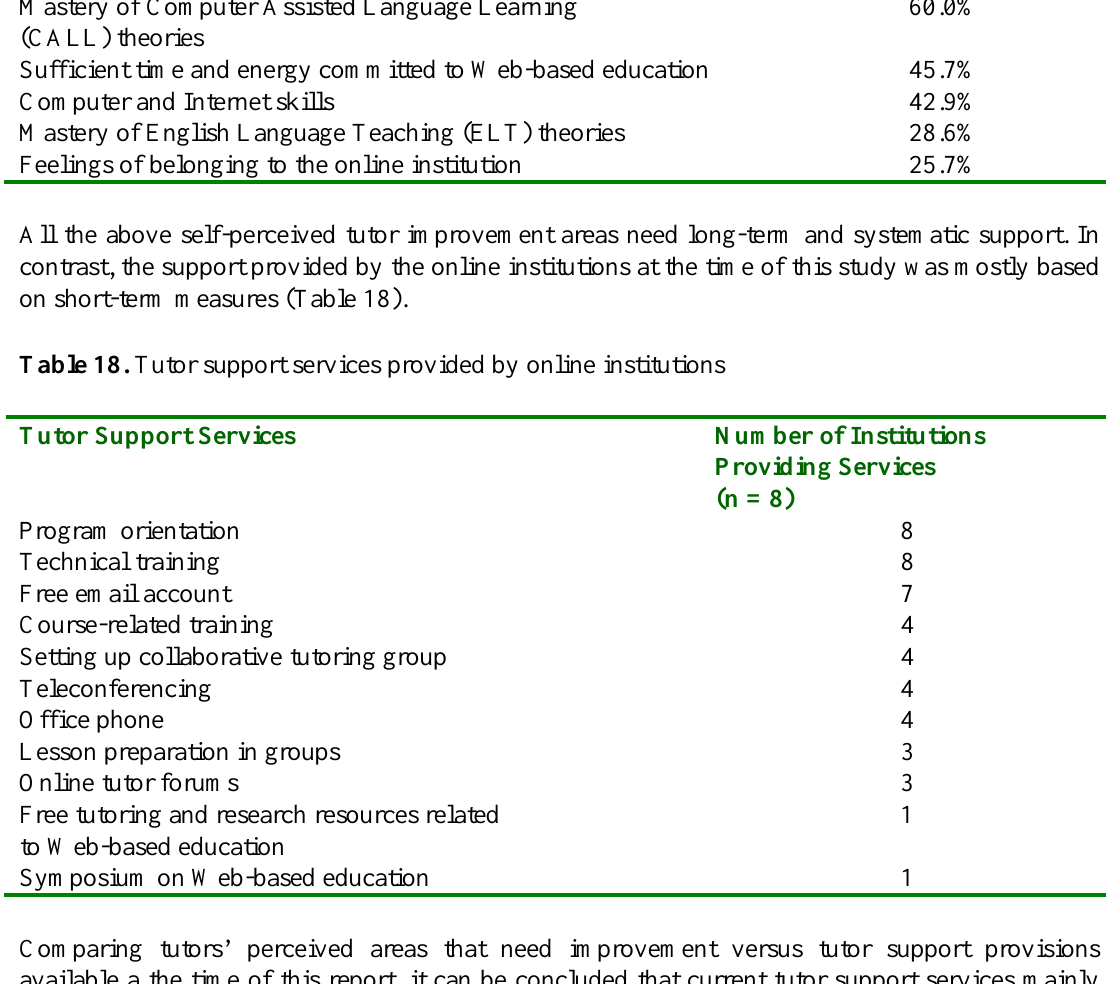
Table 17. Perceived areas for tutor improvement (tutors’ perspective) Areas for Tutor Improvement